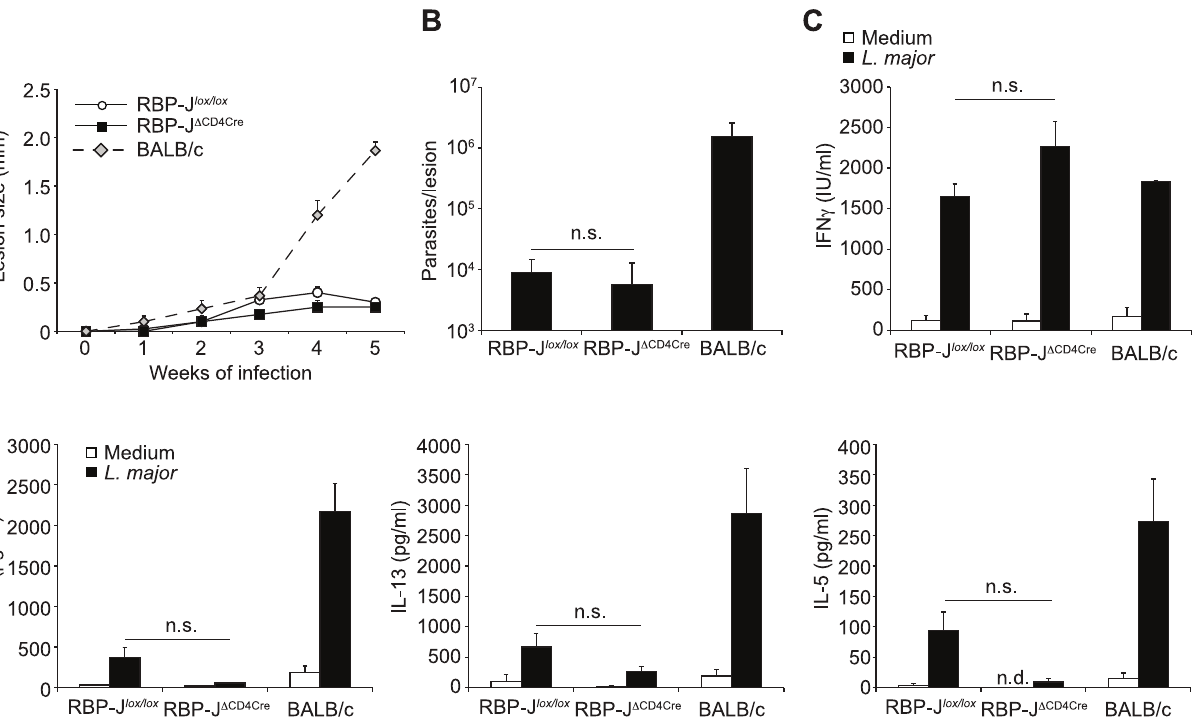
Figure 6. The impact of Notch signaling on Th1 differentiation is RBP-J k -independent. (A) RBP-J k D CD4Cre and RBP-J k lox/lox mice were infected s.c. with 3 6 10 6 L. major and lesion size measured weekly. Group mean of lesion size 6 SEM for n $ 3 mice per group is shown. (B) Parasite load in footpad was analyzed by LDA 5 weeks post infection. Data represent mean parasite number 6 SEM for n $ 3 mice per group. (C, D) IFN c (C), IL- 4, IL-13 and IL-5 (D) levels were measured in supernatant of dLN cells isolated from L. major -infected mice 5 weeks post infection and restimulated for 72 h with or without UV-treated L. major . Group mean of cytokine secretion 6 SEM is given (n $ 3 mice per group). n.s. not significant. * p-value , 0.05 versus control